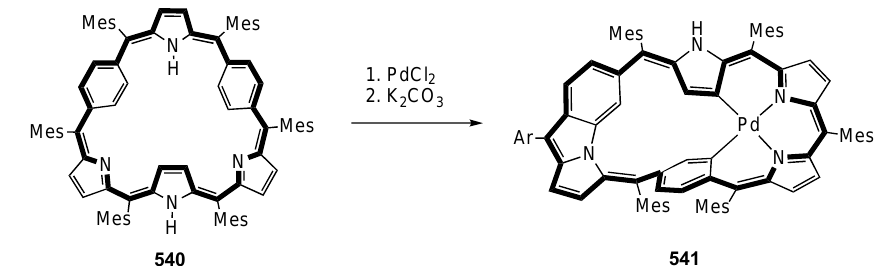
Scheme 82. Palladium complexes of a dipyrioctaphyrin.